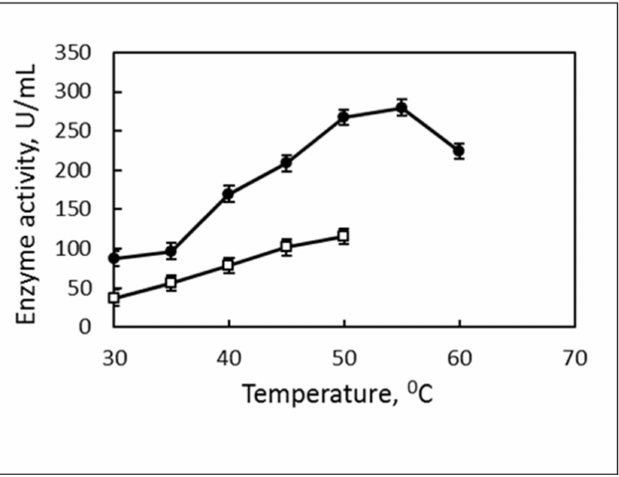
Figure 3. Substrate preference of the enzyme synthesized by a strain 7. (cid:3) , pNPB; • , pNPP.